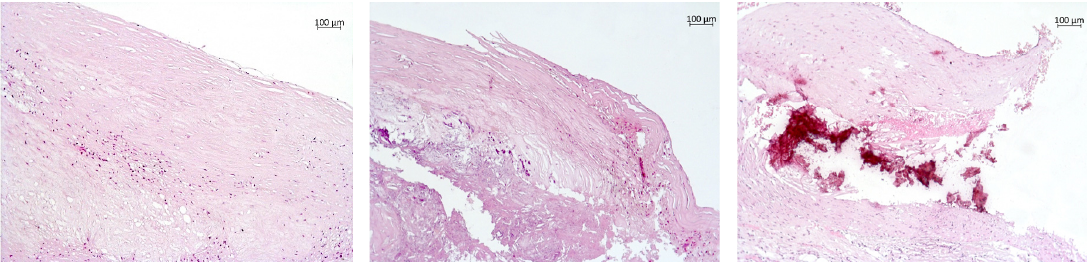
Figure 2. Atherosclerotic plaques with various degrees of calcification. ( a ) Without calcification